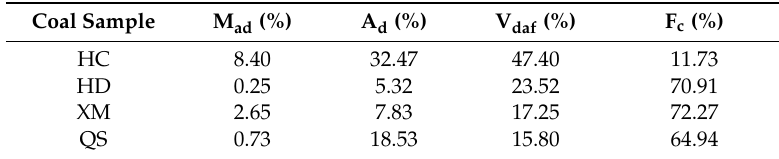
Figure 3. The diagram of coal samples collection places. Table 2. Proximate analysis results.